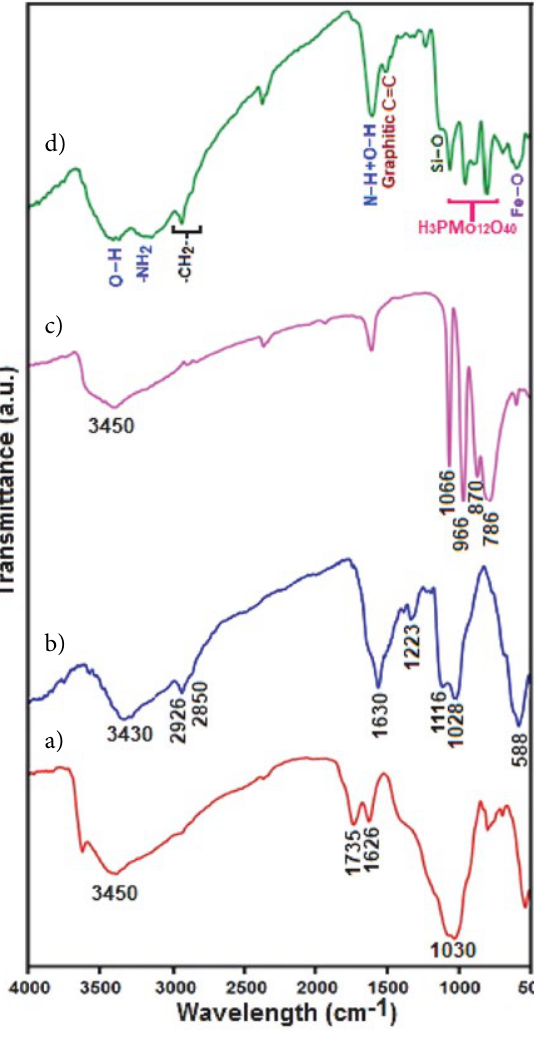
Figure 3. IR spectra of (a) pure GO, (b) Fe H